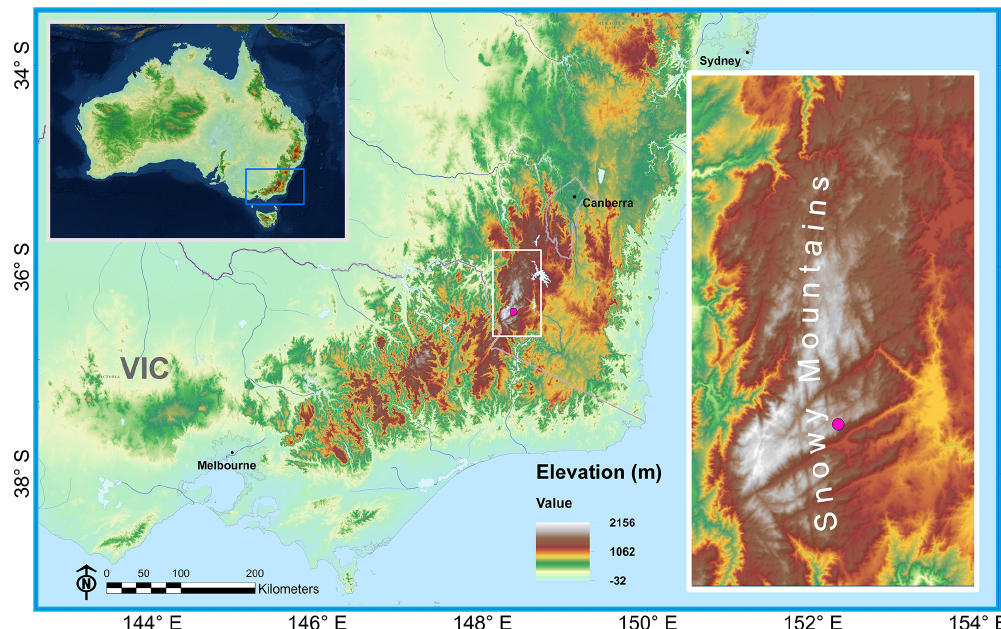
Figure 1. Map of southeast Australia and the Snowy Mountains. The pink dot represents the location of the energy balance instrumenta- tion site. Map layer source copyright: ESRI, USGS, NOAA, DigitalGlobe, GeoEye, Earthstar Geographics, CNE S/A Airbus DS, USDA, AeroGRID, IGN, and the GIS user